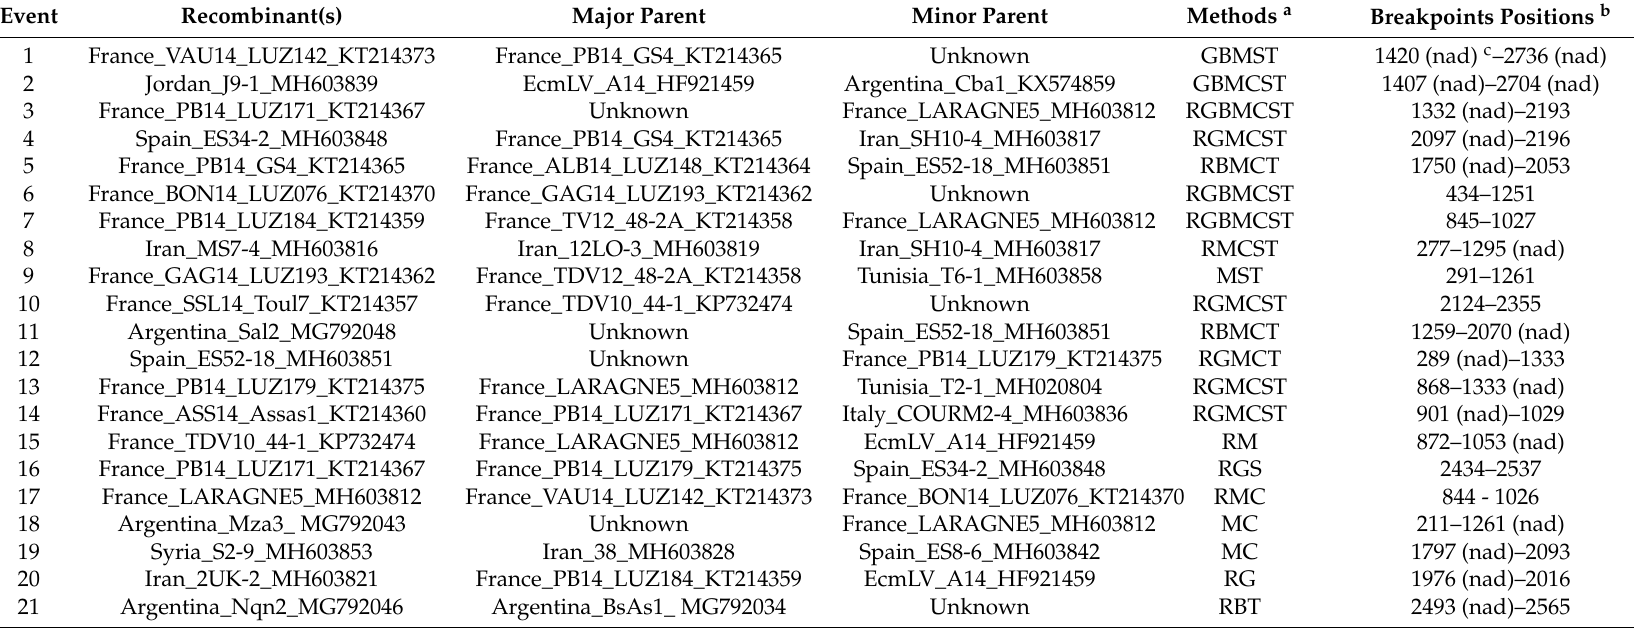
Table 2. Recombination events detected in alfalfa leaf curl virus